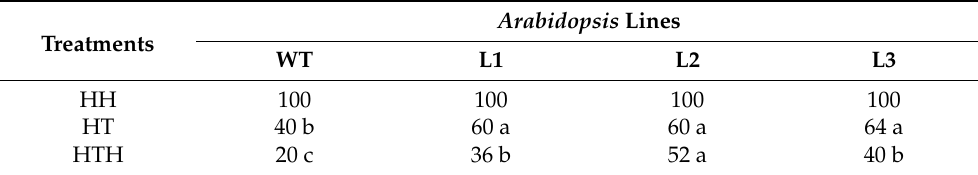
Table 1. Germination rate (%) of seeds harvested from the GmATX1 -overexpression Arabidopsis lines (L1, L2, and L3) and WT after 2 d of different treatments.